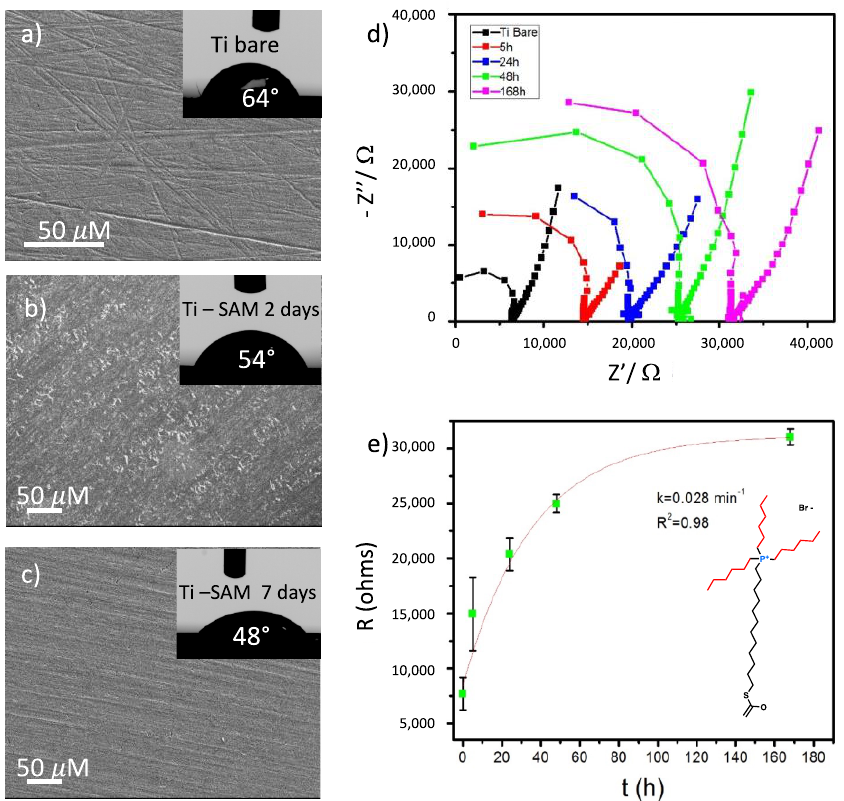
Figure 2. ( a – c ) SEM micrographs of titanium bare surface, Ti-SAM of 3 after 2 days and after 7 days, respectively. Inset: contact angle images. ( d ) Nyquist plots for Ti-SAM of 3 using agarose gel 1% as solid electrolyte. The frequency range was 0.1 Hz to 100 MHz, frequency increases from right to left, and an excitation signal of 25 mV peak amplitude was applied; OCP vs. platinum wires as reference and counter electrode. ( e ) Resistance (Ohms) vs. time (hours) adsorption isotherm fit for the set of data.